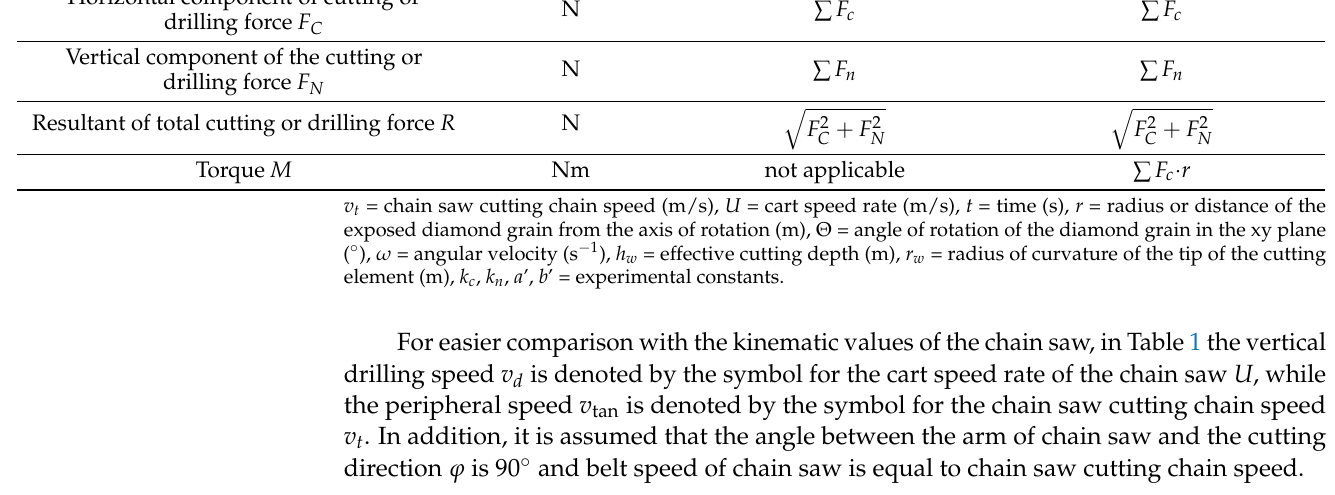
Chain Saw Rotary Drill